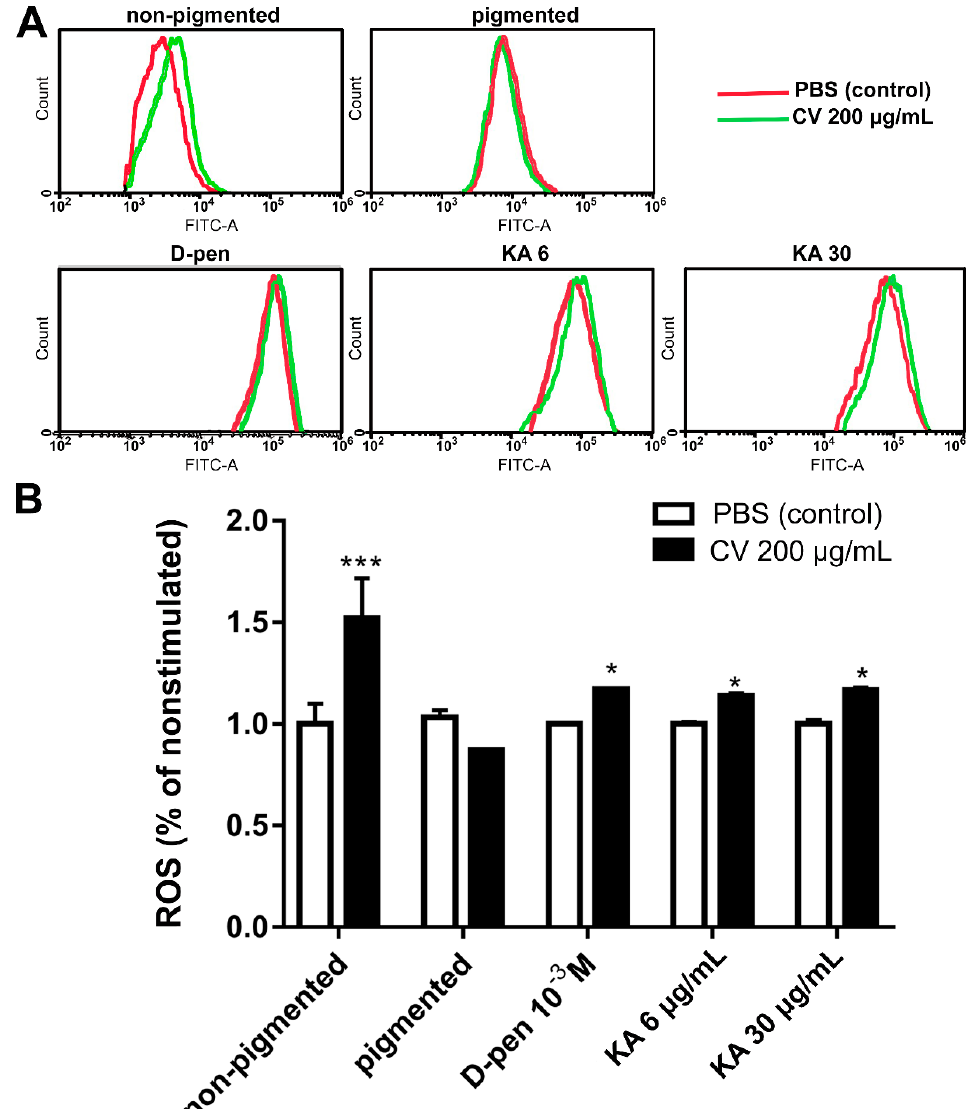
Figure 4. Coriolus versicolor (CV) extract induces reactive oxygen species (ROS) production in depigmented melanoma cells. Flow cytometry analysis visualized the amount of ROS generated in non-pigmented SkMel-188 cells (control for the study), pigmented, and melanogenesis inhibitors pre-treated SKMel-188, after CV (200 µ g/mL) cells stimulation. ( A ) representative images of ROS generation shift upon CV stimulation of cells. The red line represents ROS production in cells incubated with PBS, green line refers to CV-stimulated group. ( B ) The relative levels of ROS in SKMel-188 cells are presented as fold change compared to PBS incubated cells. Data are reported as means ± SEM of three independent experiments. Asterisks indicate significant differences between control, PBS-treated cells, and CV-stimulated cells (* p < 0.05, *** p < 0.001). Abbreviations: non-pigmented—amelanotic SkMel-188 cells cultured in Ham’s F10 medium, pigmented—melanotic SkMel-188 cells cultured in DMEM medium, PBS—phosphate-buffered saline; CV— Coriolus versicolor extract; D -pen— D -penicillamine 10 − 3 M; KA—Kojic acid 6 or 30 µ